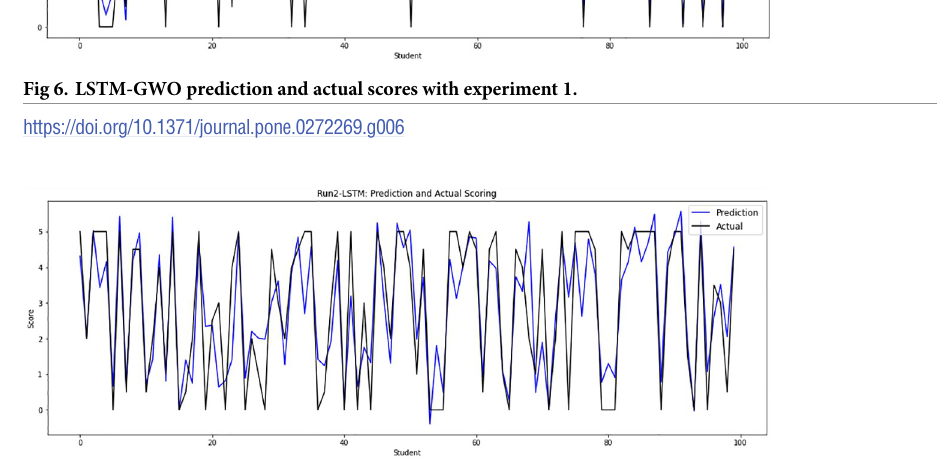
Fig 7. LSTM-GWO prediction and actual scores with experiment